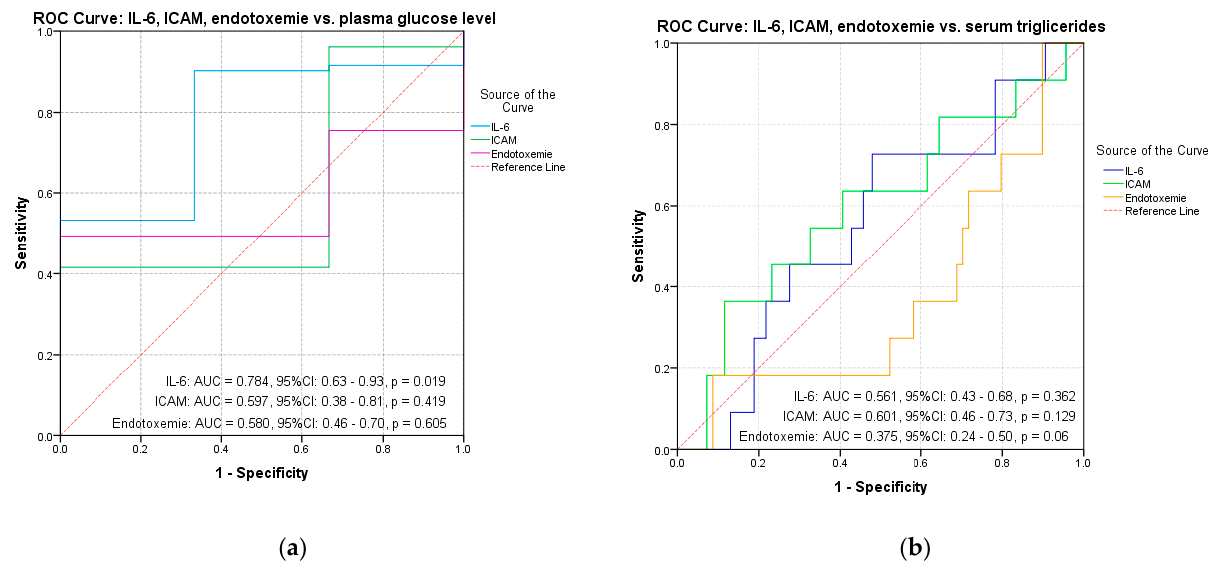
Figure 3. ROC curves for IL-6 and ICAM and endotoxemia vs. ( a ) plasma glucose level and ( b ) serum triglycerides. 3.3. Identifying Cut-Off Values for Inflammatory Markers in Obese Children and Adolescents Demonstrating the predictive power of BMI percentile and plasma glucose levels, we identified baseline cut-off values for IL-6, ICAM and endotoxemia for obese children and adolescents with early vascular damage (Figure 4).